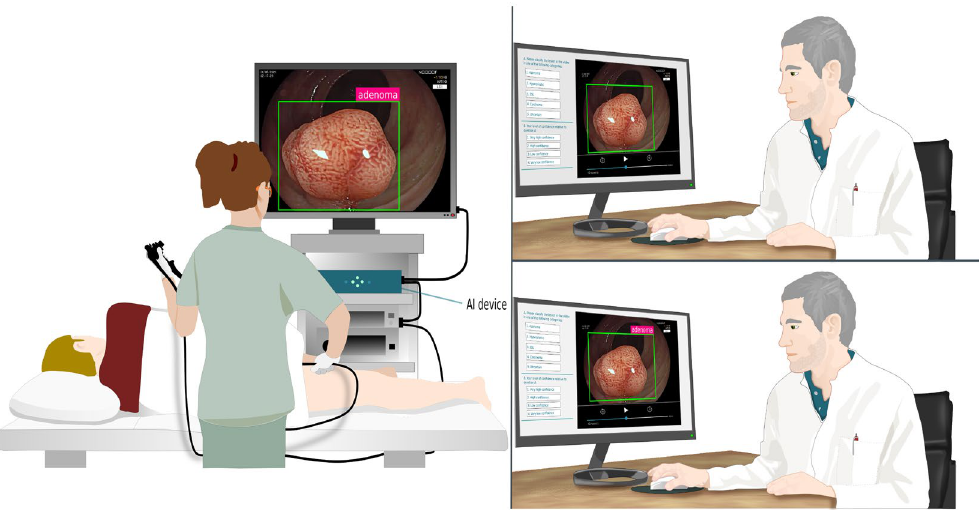
Figure 1. Left panel: The stimuli used in the experiment were prospectively collected in a real-world clinical setting using an ai medical device supporting mds for lesion detection (cade) and categorization (cadx) as adenomatous or non-adenomatous 24 . Right panel: An international group of endoscopists were asked to optically diagnose the same set of lesions, presented as short video clips, in two experimental sessions. In the first session (top-right panel) the ai only highlights the target lesion, while in the second session (bottom-right panel) ai also dynamically offers an optical diagnosis. For more details on the ai device see Appendix